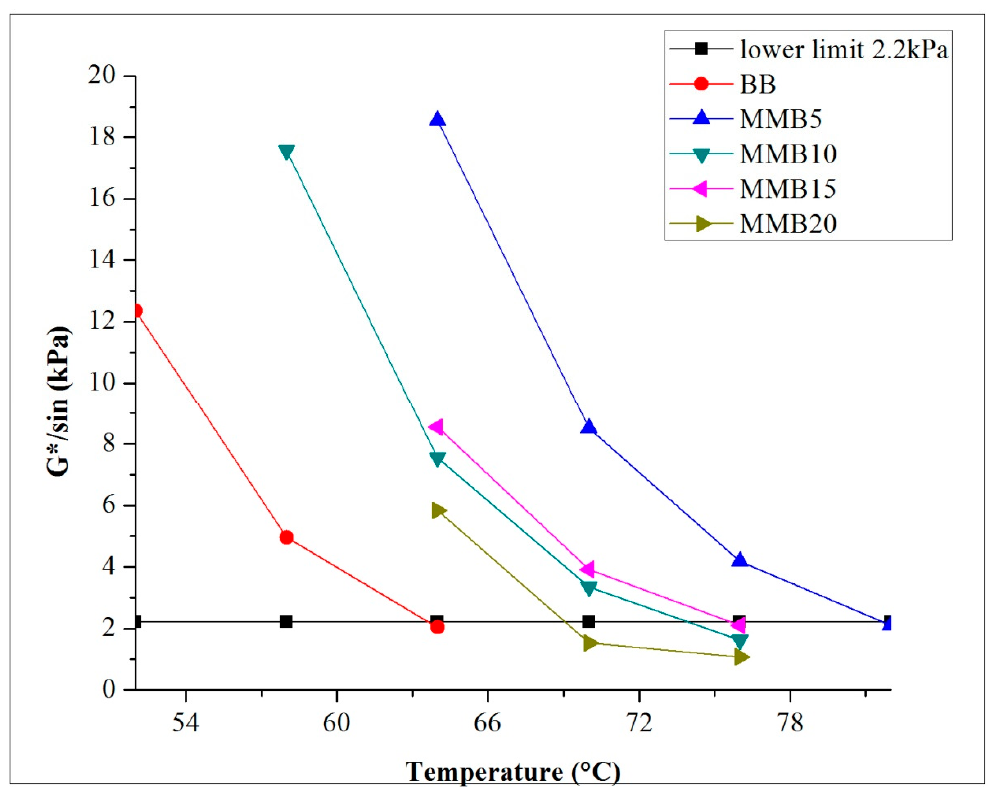
Figure 6. PG grade limit for rolling thin film oven (RTFO)-aged